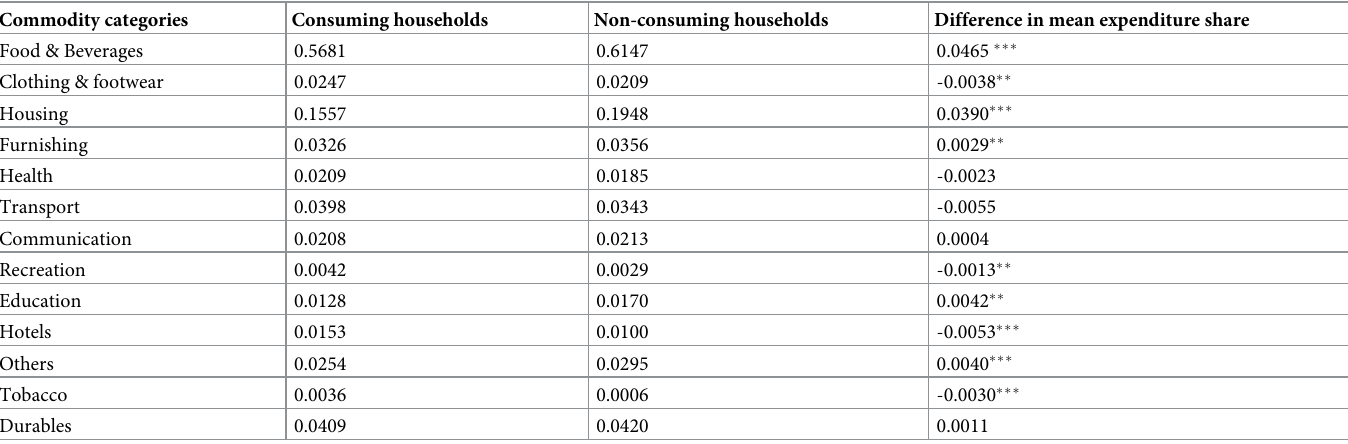
Table 2. T-Test for the differences in mean of shares between alcohol consumers and non-consumers for the full